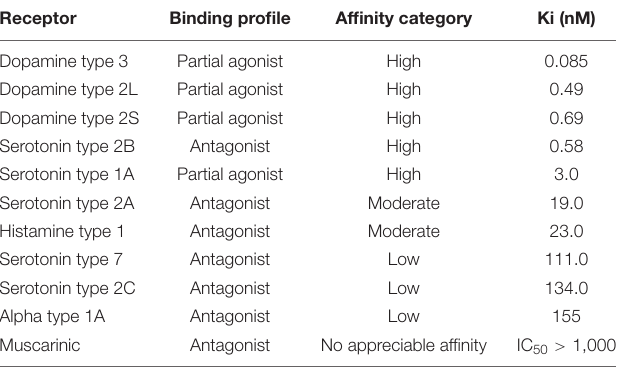
TABLE 1 | Receptor profile and binding affinities of cariprazine.